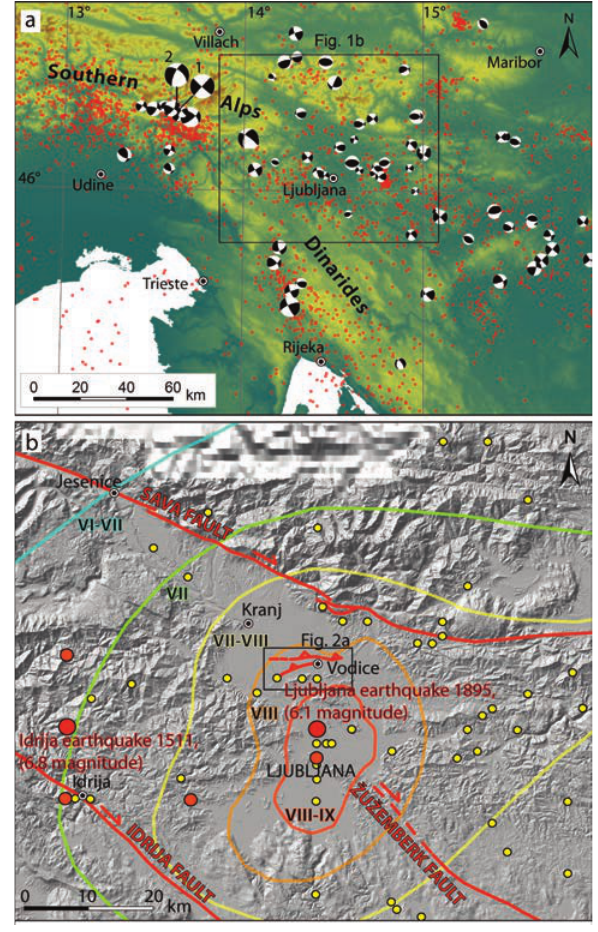
Figure 1. (a) Instrumental seismicity of the SE Alps and NW part of the Dinarides (ANSS catalogue, 1976-2012) and earthquake focal mechanisms [Bajc et al. 2001, Zupan č i č (cid:0) et al. 2001, Kastelic et al. 2006, 2008, Ložar Stopar and Živ č i č (cid:0) 2007, 2008, 2011, 2012, (cid:0) Č ar- man et al. 2010]. 1 - focal mechnism of the 1998 Ms 5.7 [Bajc et al. 2001], and 2 – focal mechanism of the 2004 Mw 5.2 earthquake [Kastelic et al. 2006]. Square indicates the location of Figure 1b. To- pography is SRTM 90 m, available from the Global Land Cover Fa- cility (http://glcf.umd.edu/data/). (b) Main active faults of the Ljubljana Basin [modified after Buser 2009]. Historical earthquake epicentres with magnitude above 3.9 are from Živ č i č (cid:0) [2009]. Earth- quake magnitudes are obtained from macroseismic data. Locations of historical earthquake epicentres are not well constrained. Iso- seismal contours of the 1895 Ljubljana earthquake according to La- pajne [1989]. Shaded relief obtained from processing of DEM 5 m (Public Information of Slovenia, the Surveying and Mapping Au- thority of the Republic of Slovenia, DEM 5, 2006). Square indicates the location of Figure